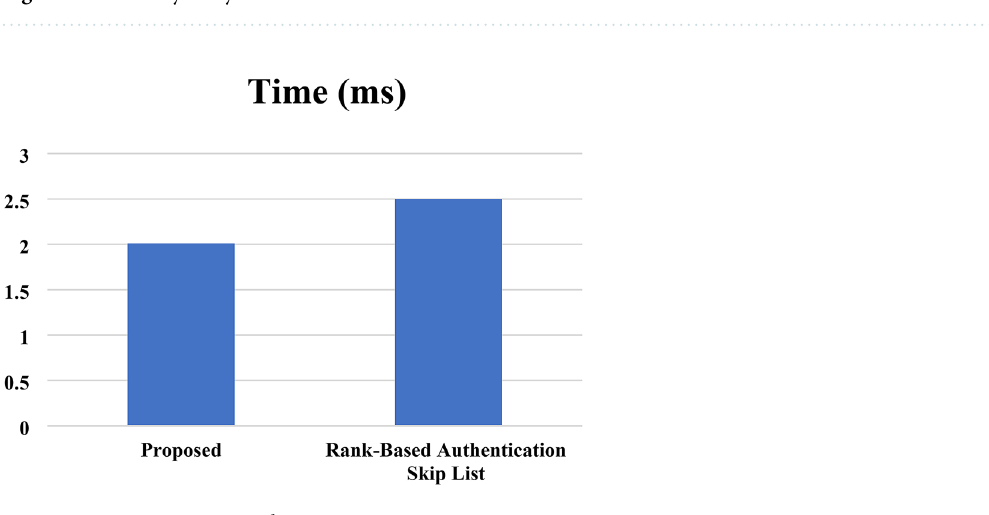
Figure 5. Execution time